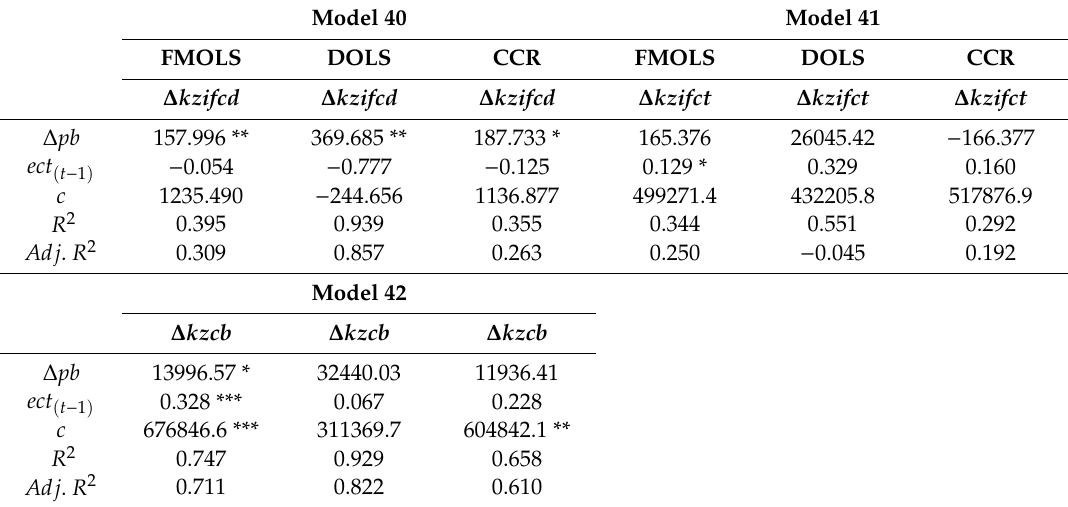
Table 18. The influence of oil price on macroeconomic indicators